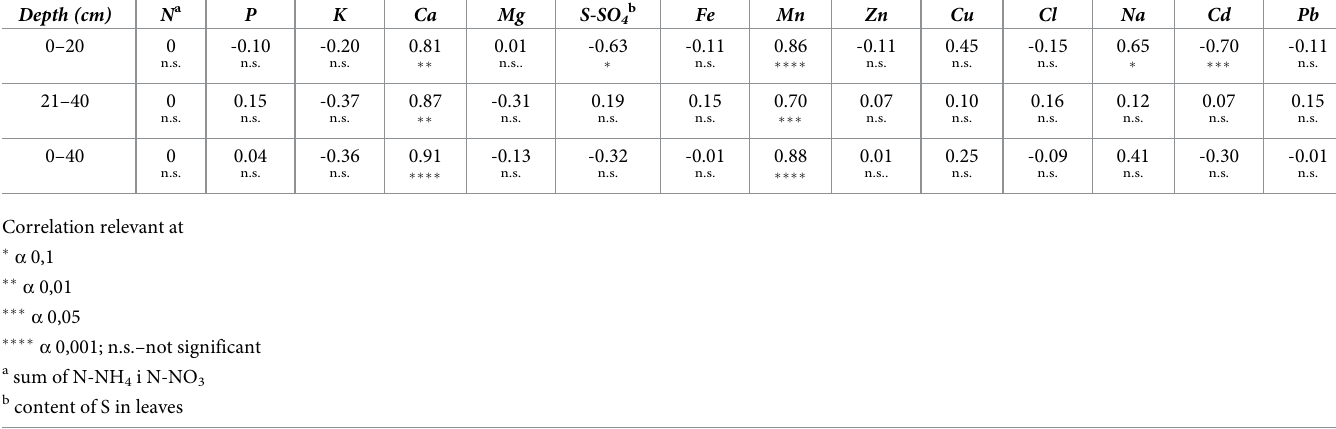
Table 6. Pearson correlation coefficients between the content of macro- and microelements, Na and heavy metals in the soil and in lime-tree leaves. Depth (cm) N a